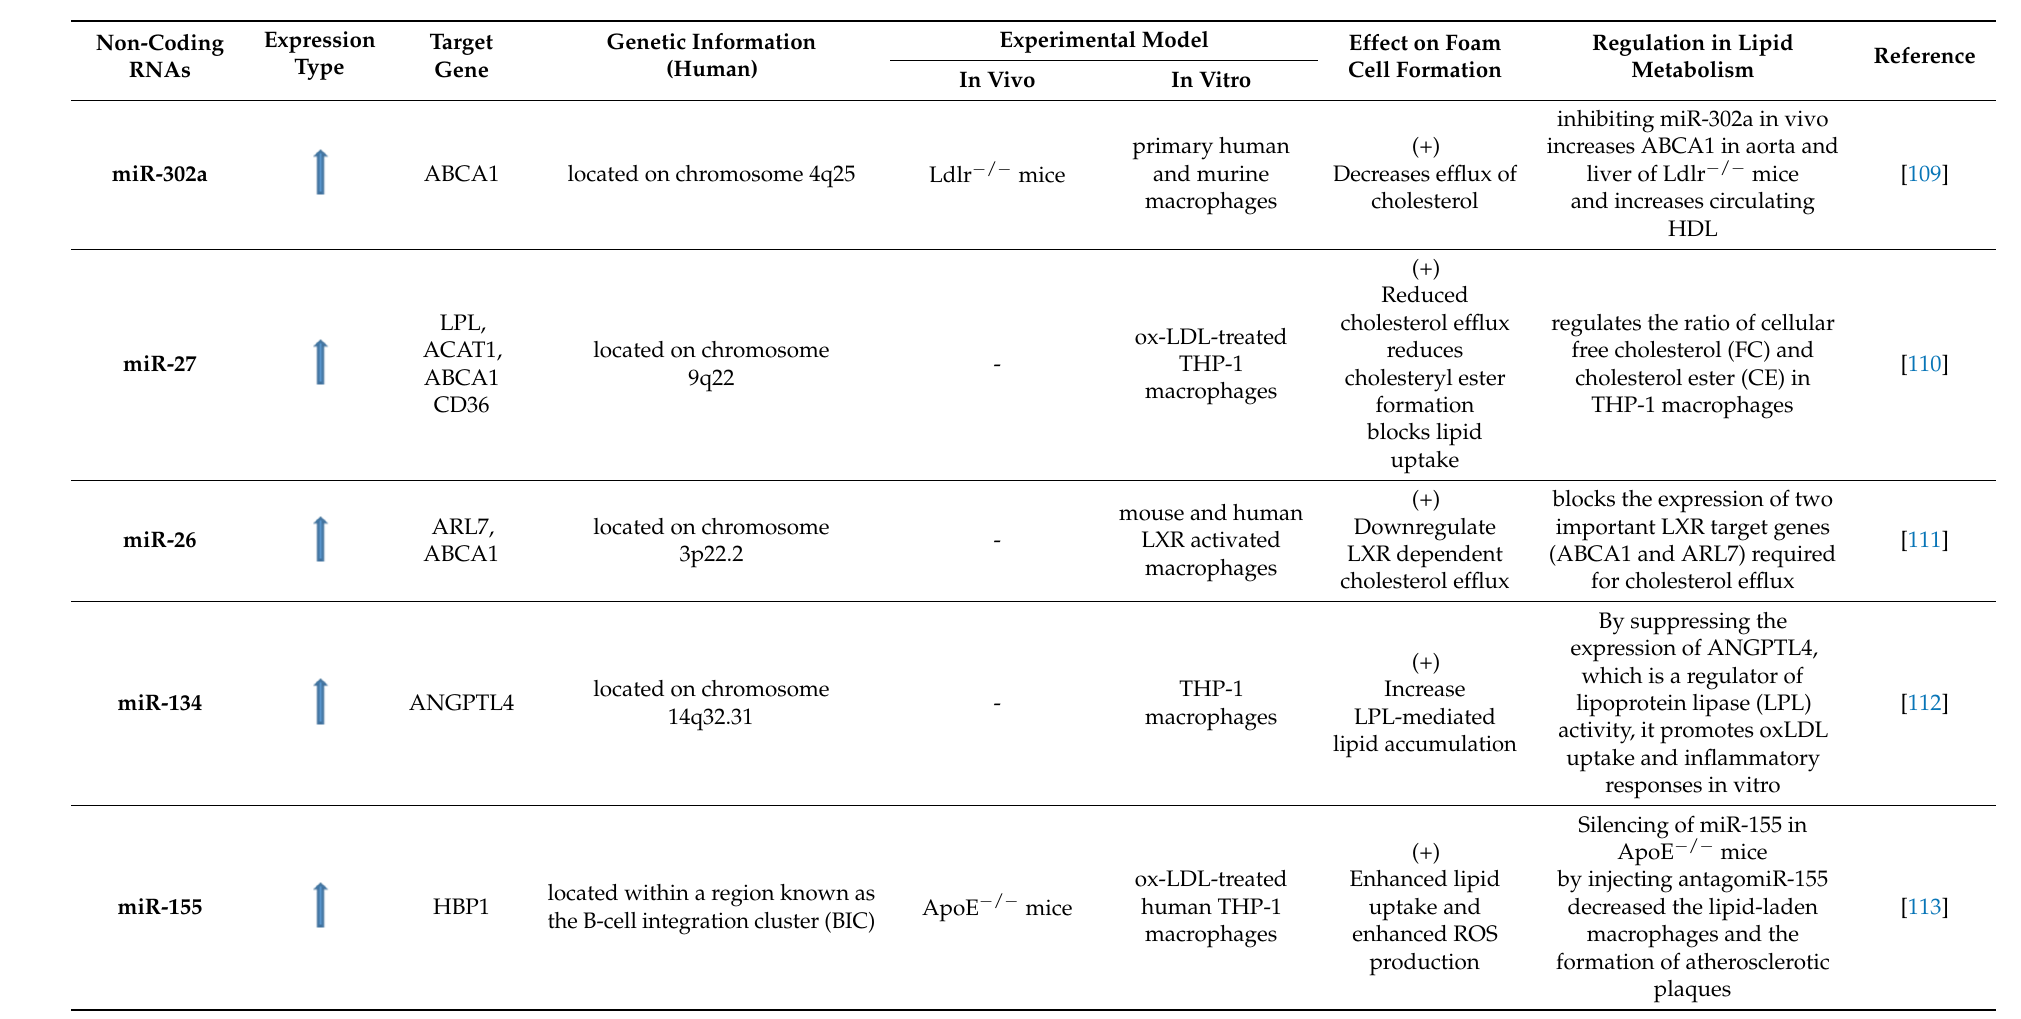
Table 1. Non-coding RNAs that stimulate foam cell formation/function. Table 1. Cont .